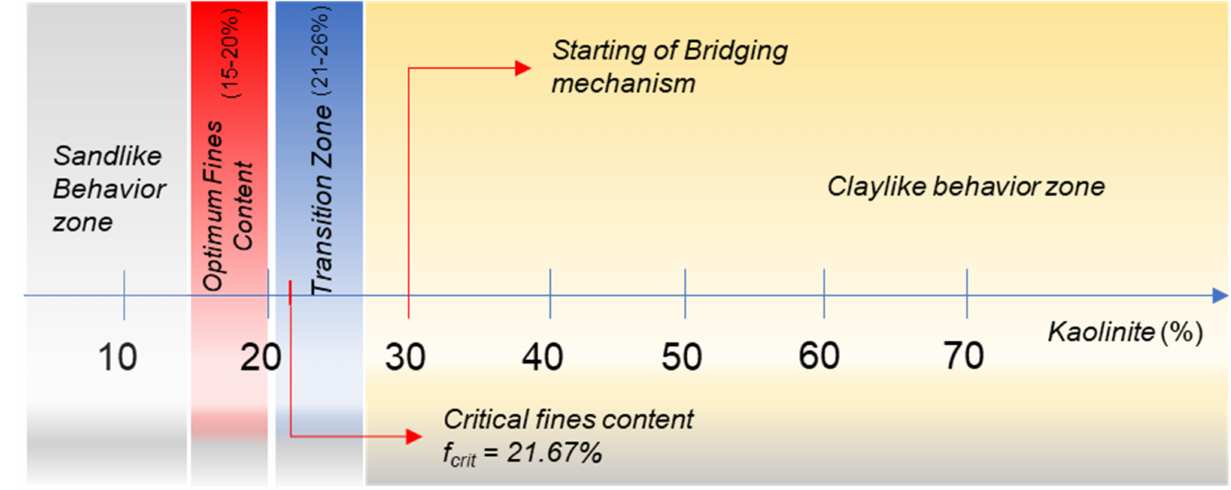
Figure 12. Overall behavioral of the